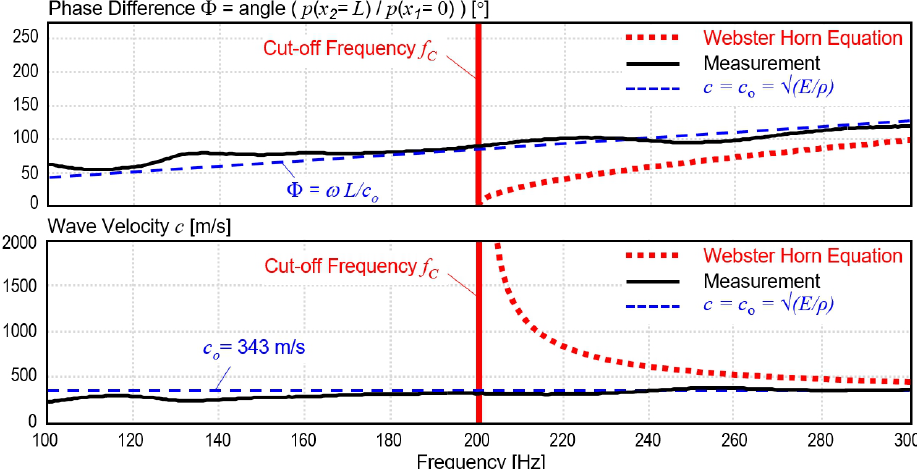
Figure 10. Exponentional horn measurement [23]. The top graph shows the measured phase angle Φ and the bottom graph the calculated wave velocity c = 2 π f L / Φ . The sound propagates with a linear phase and a wave velocity of c ≈ 343 m/s, see black lines. The predictions of the Webster horn equation are displayed with red lines. The conditions for conformity with the Principle of Locality (cid:112) E / ρ ) are shown with blue lines. The measurement indicates, that the sound waves in ( c = c o = the exponential horn with reflectionless termination travel with speed of sound at/below cut-off frequency f C = 200 Hz. This is in contrast to the predictions of the Webster horn